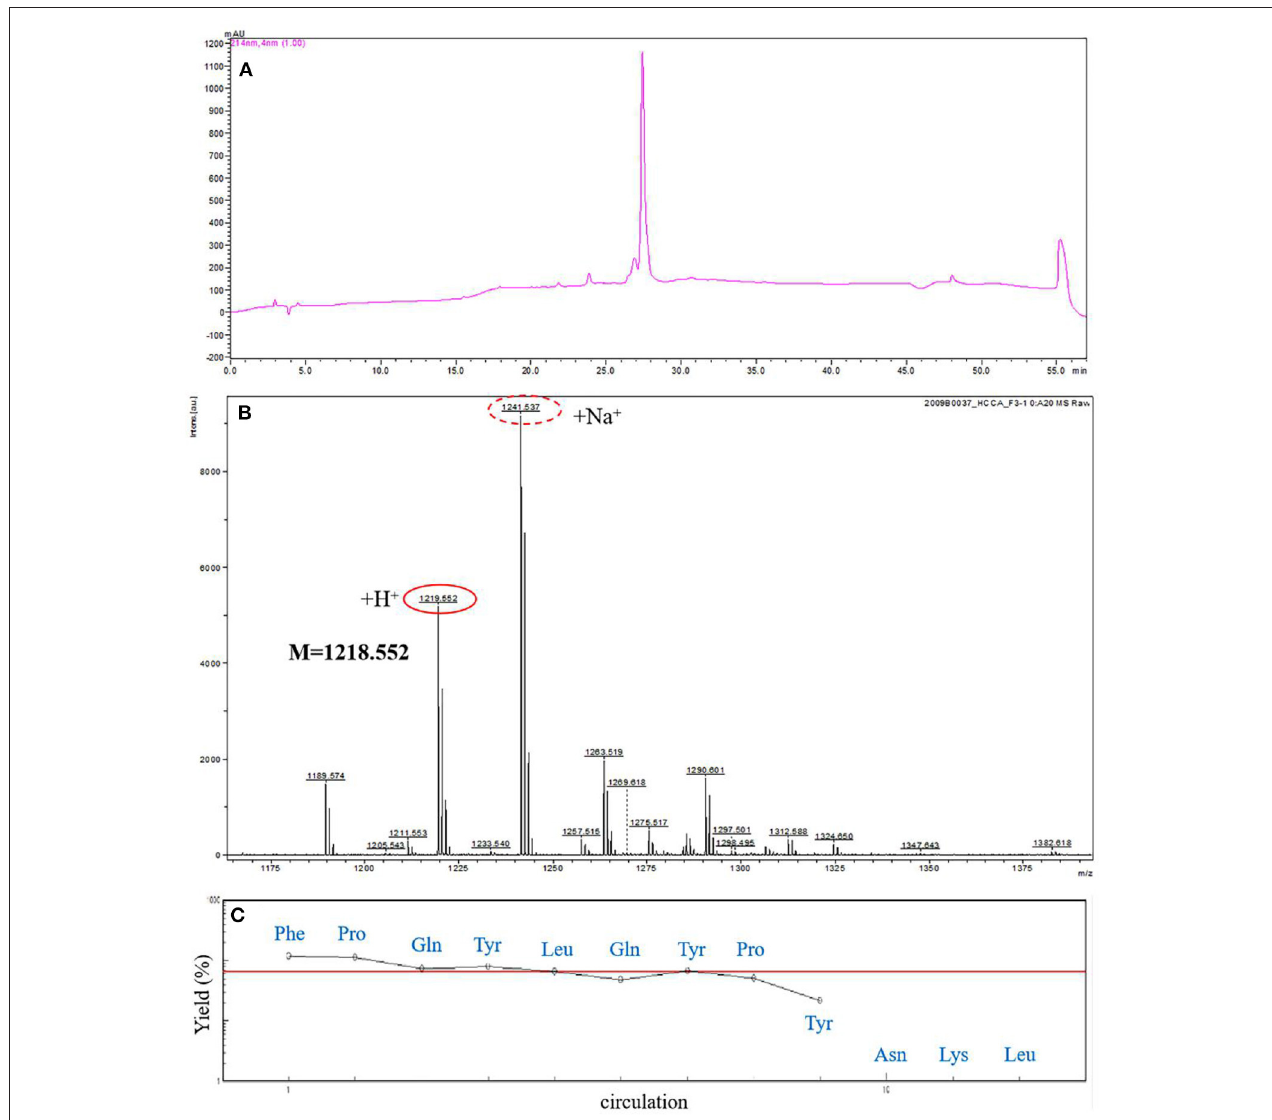
FIGURE 2 | Amino acid sequence analysis of F3. (A) Further analysis of F3 by analytical RP-HPLC. (B) The molecular mass analysis of the ACE-inhibitory peptide F3 by MALDI-TOF-MS/MS. (C) The N-terminal sequence analysis of F3 by